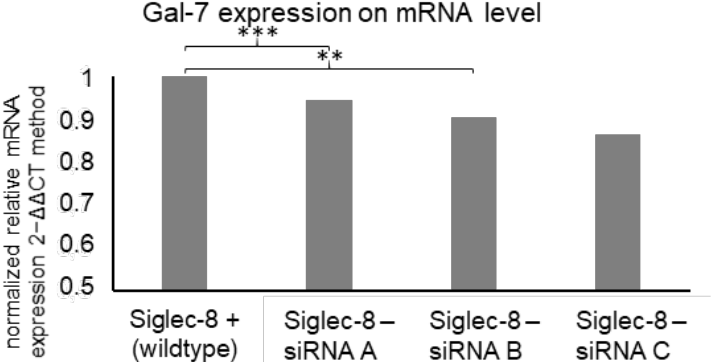
( b ) Figure 6. ( a ) Mean relative Siglec-8 expression on mRNA level (calculated with 2 −ΔΔCT method) in different cell lines, Glyceraldehyde-3-Phosphate Dehydrogenase (GAPDH) was used as endoge- nous control for ΔCT-values and the results are means of triplicates. ( b ) Mean relative Siglec-8 expression on protein level (as % of βActin expression) in different lines. Beta-Actin was used as a loading control and for normalization and results are the mean of triplicates. Exemplary Western Blots are displayed below the graph. 2.4.2. Siglec-8 Knockdown and Gal-7 Expression Due to the correlation of Siglec-8 and Gal-7 expression and their combined prognostic